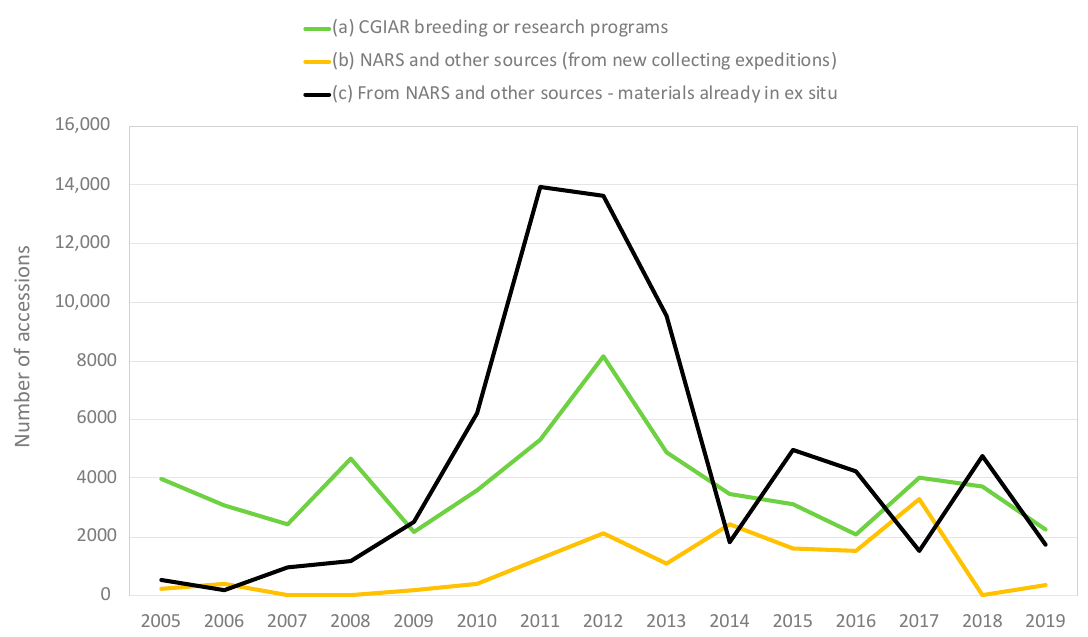
Figure 2. Details of CGIAR genebank acquisitions 2005–2019 .